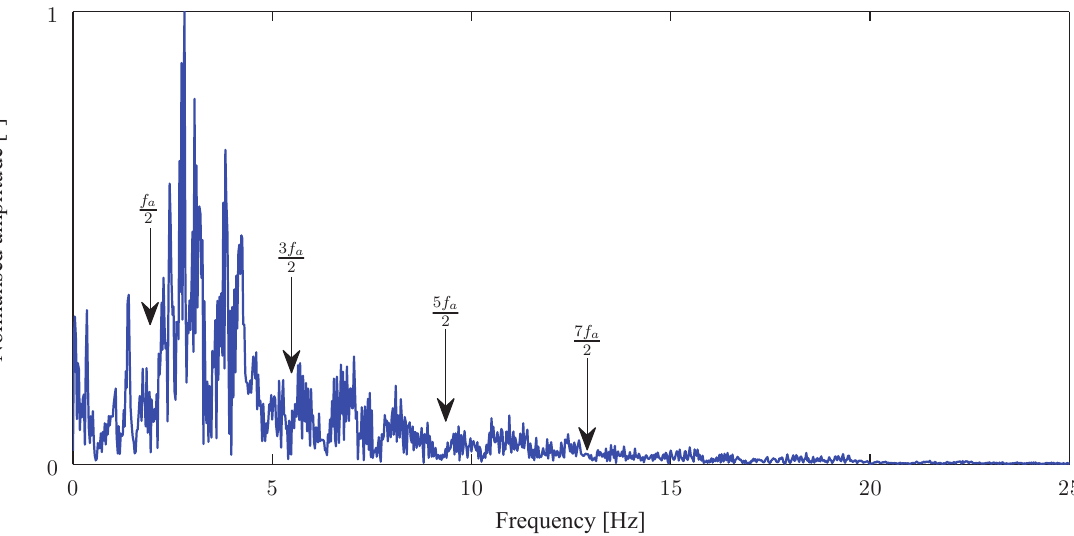
Figure 14. Frequency content of the signal presented in Figure 13 ( L